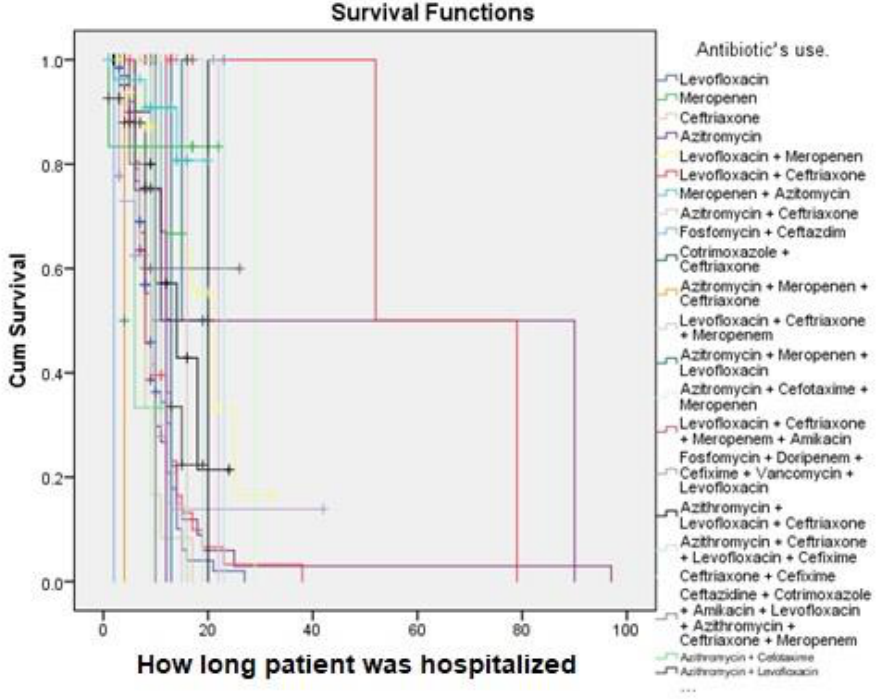
Figure 5. Kaplan – Meier survival analysis of the antibiotic used.